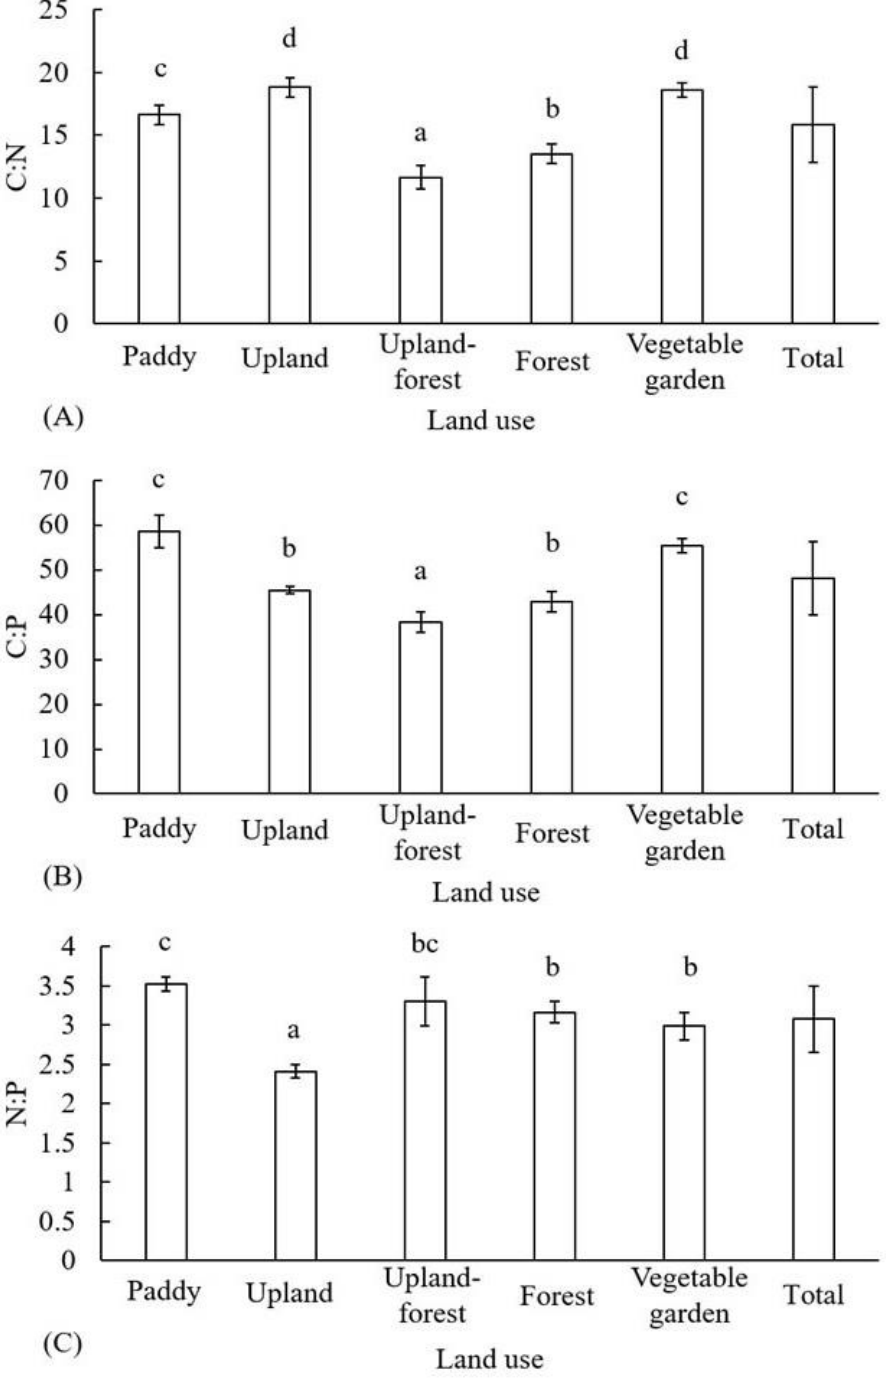
Figure 2. Topsoil stoichiometric characteristics (mean ± S.D.) of C:N ( A ), C:P ( B ), and N:P ( C ) under different land-use types ( n = 5 for each land-use type, n = 25 for total, different letters mean significant difference occurred).